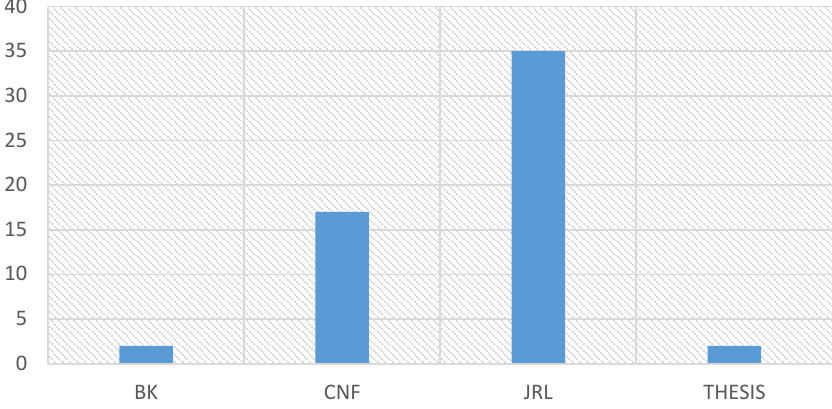
Figure 6. Type of the studied publications.